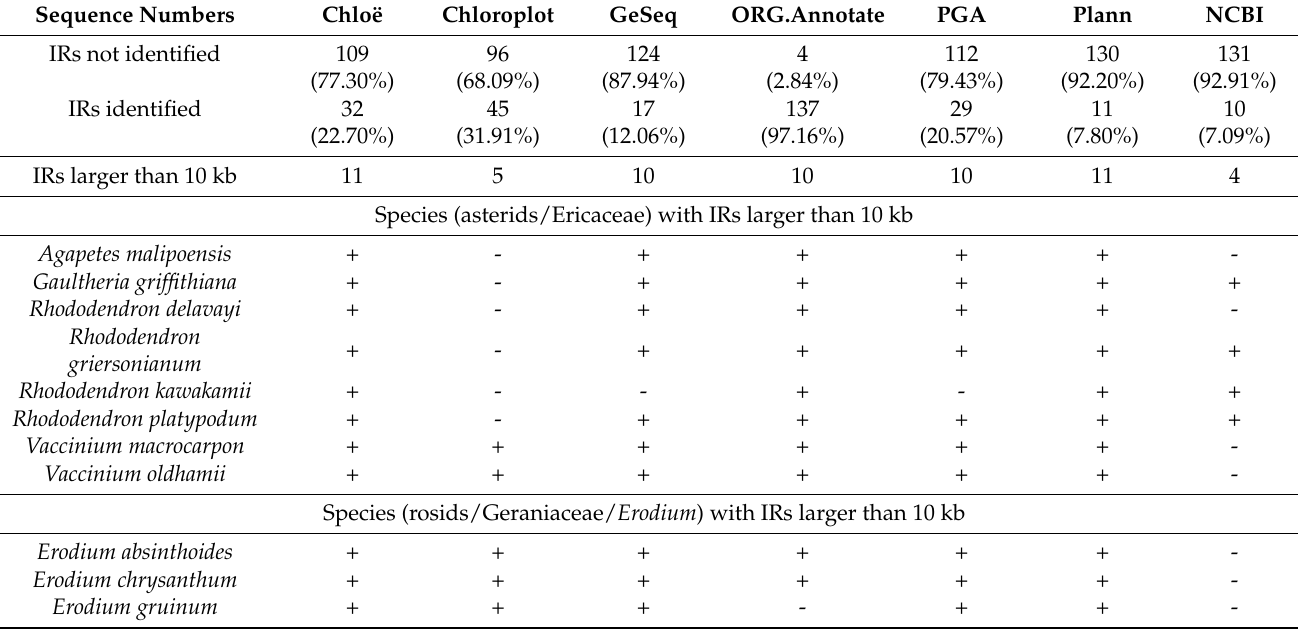
Table 2. Identification of inverted repeats in sequences of the inverted repeat-lacking (IRL) dataset and the list of species with IRs larger than 10 kb detected using six annotation tools (and those annotated in